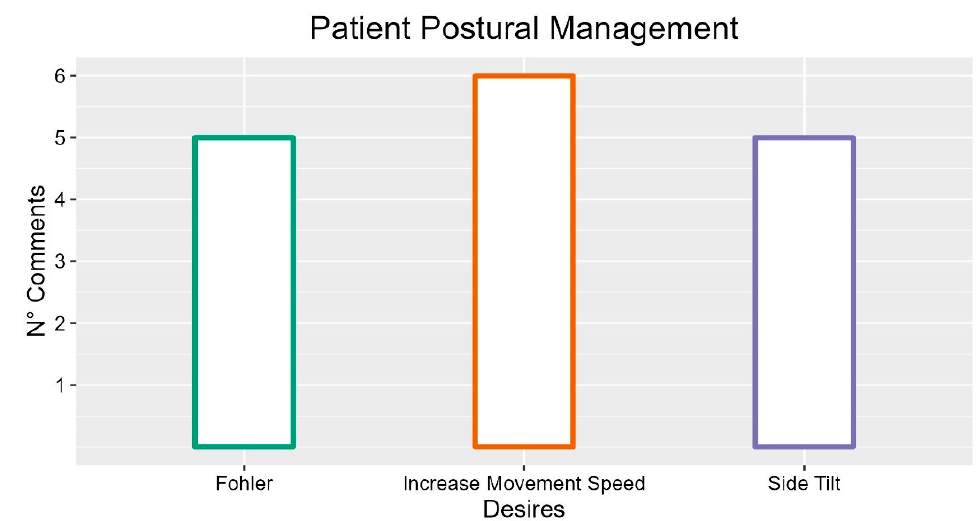
Figure 8. Graphical representation of desires with more occurrences for the Patient Postural Management theme.